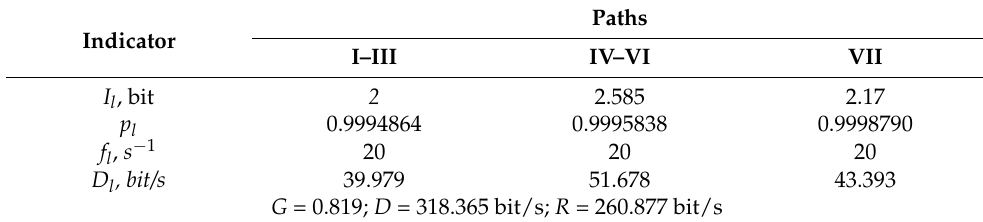
Table 3. Determination of informational indicators in the Parallel System.